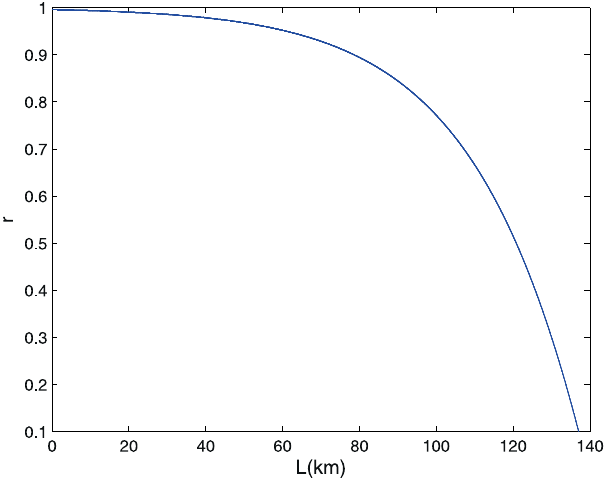
Figure 2. Lower bound on the key rate (per sifted key bit) versus fiber channel transmission from Charlie (EPR source) to Alice (Bob). A secret key rate with perfect single-photon states is illustrated. We show the simulation result of four identical quantum channels for the given